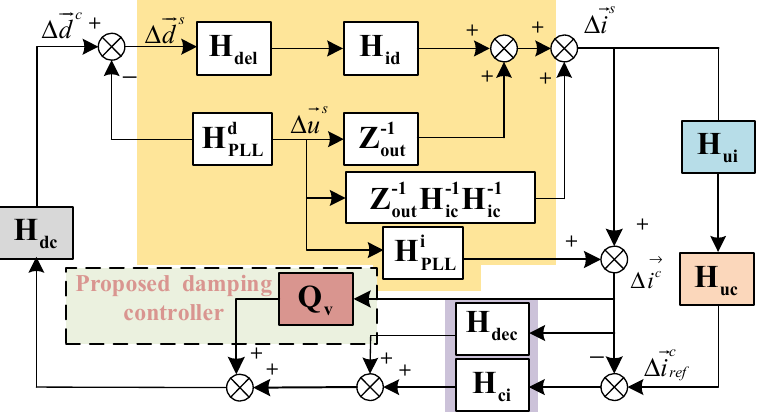
Figure 10. Small-signal control block diagram of LCL-TFSCI after impedance reshaping.